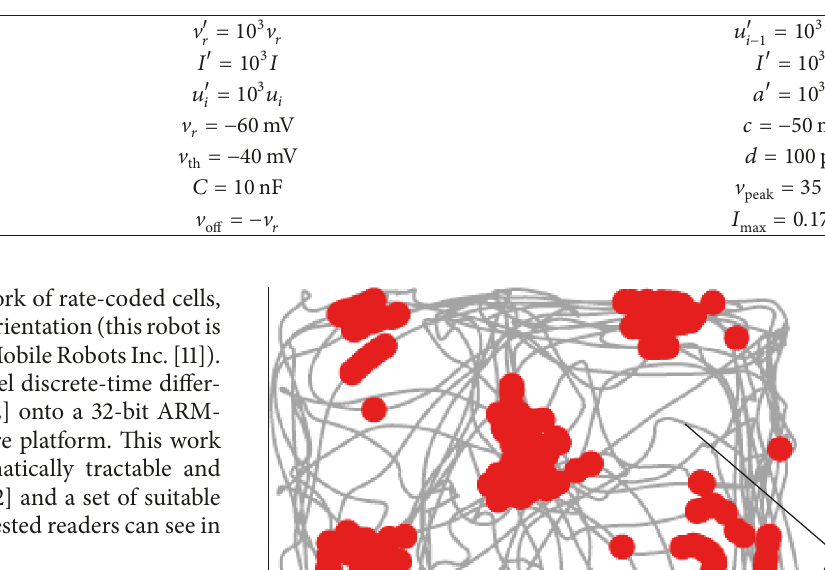
Table 1: Scaled variables and parameters values used for equations (3), (4), and (5).